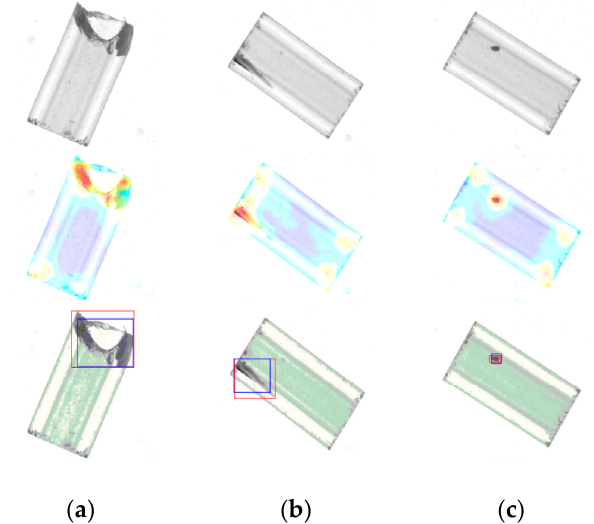
Figure 10. Examples of localization on the diode glass bulb surface defect dataset. From top to bottom are the original image, the combination of the original image and the heat map, and the location results of these defects. The Ground-Truth of the defect is marked with the red bounding boxes, while the localization results of the proposed method is marked with the blue bounding boxes. ( a ) break; ( b ) shell wall damage; ( c ) stain.